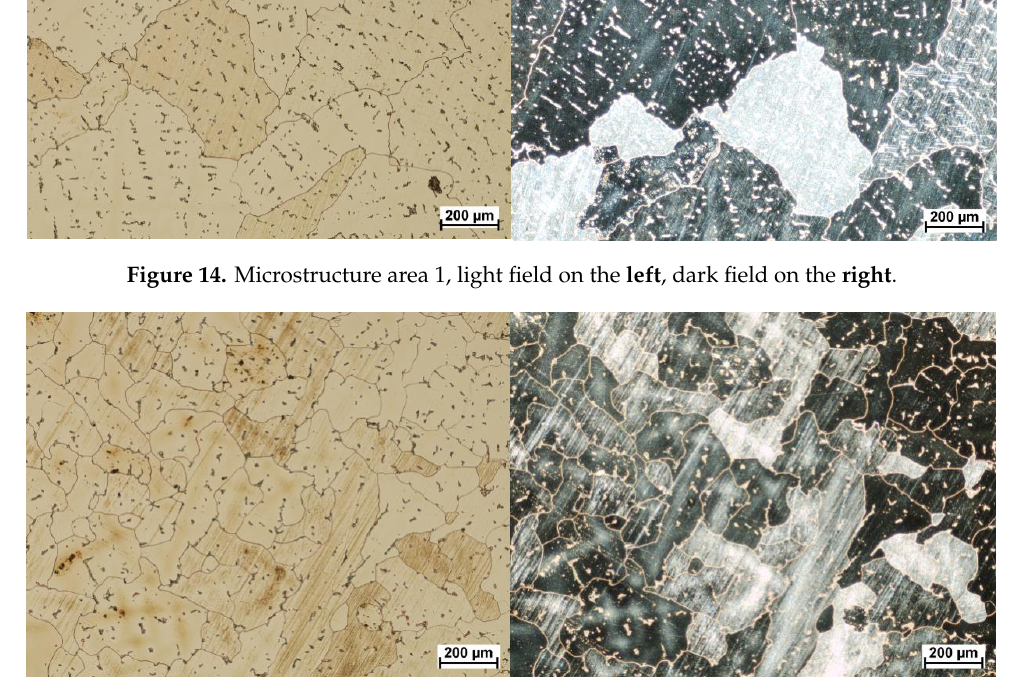
Figure 15. Microstructure area 2, light field on the left, dark field on the right.